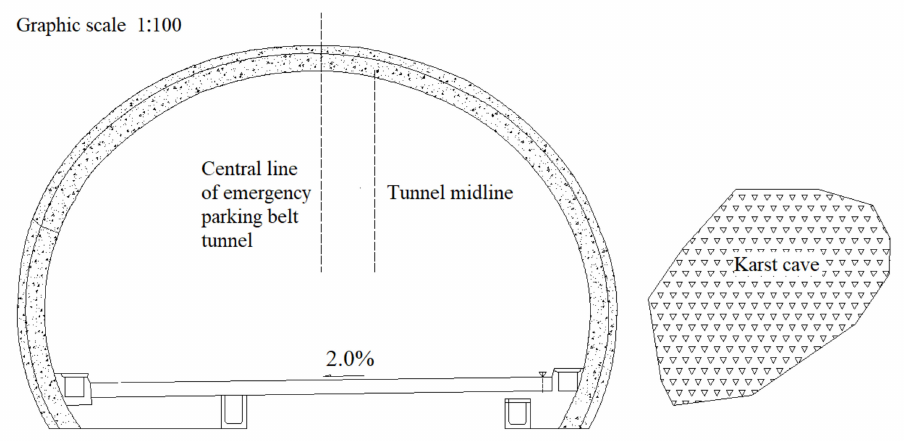
Figure 4. The left line of the Shangjiawan Tunnel exposes the development of a karst